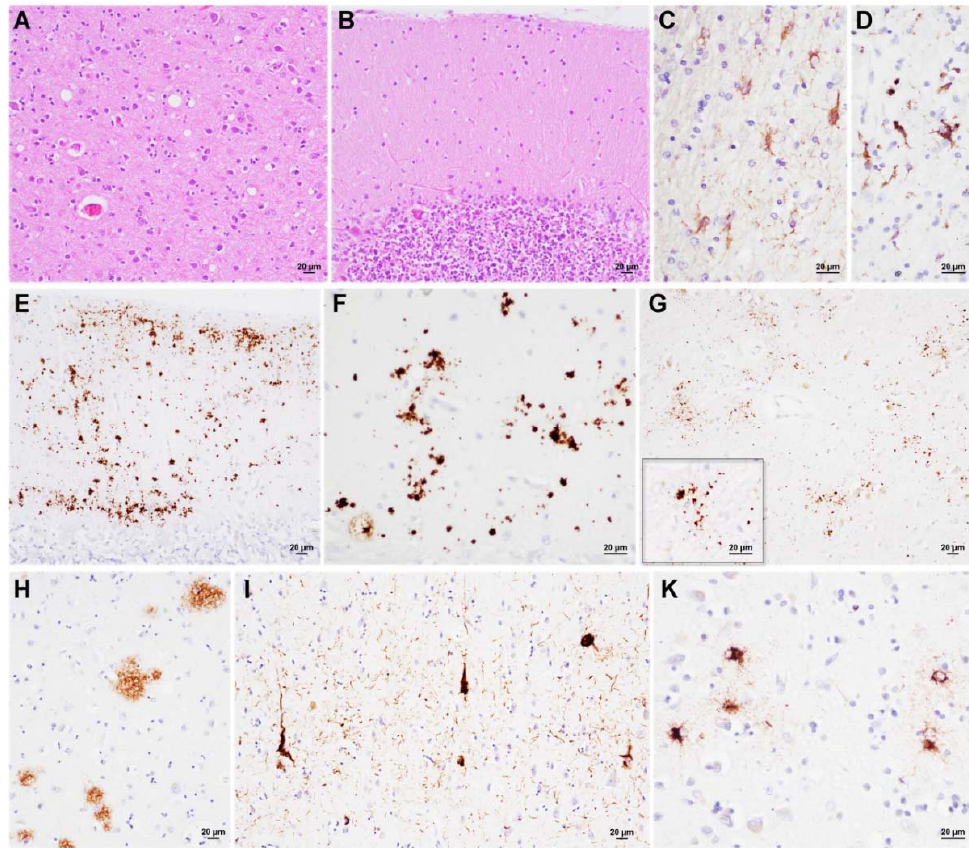
Figure 3. Neuropathological features of VPSPr 129VV (Case#3). ( A , B ) Mild spongiform change that was characterized by a mixture of small and intermediate size vacuoles in the occipital cortex and cerebellum. ( C , D ) Astro ‐ and microglial activation in the temporal gray and occipital white matter, respectively. ( E , F ) PrP granular and mini ‐ plaque deposits in the occipital cortex. ( G ) Clusters of dot ‐ like PrP deposits in the medial thalamus. On the left, the lower box shows a detail at higher magnification. ( H ) Diffuse A β deposits in the frontal cortex. ( I ) Tau ‐ positive globular and flame ‐ shape neurofibrillary tangles and neuropil threads in the entorhinal cortex. ( K ) Fuzzy tau ‐ immunoreactive astrocytes in the occipital cortex. Haematoxylin ‐ eosin staining ( A , B ), and immunochemistry for